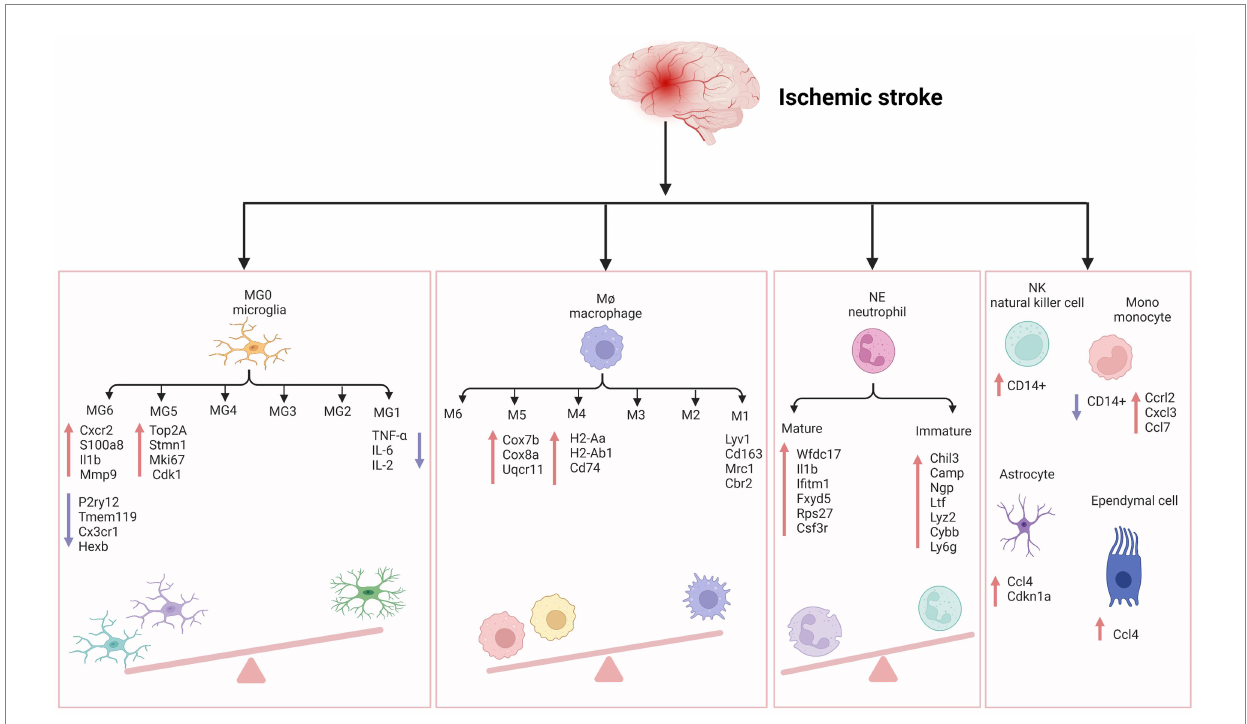
FIGURE 1 The inflammatory reaction of ischemic stroke. MG, microglia; Cxcr2, cxc chemokine receptor 2; Il1b, interleukin-1 beta; Mmp-9, matrix metallopeptidase 9; P2ry12, recombinant purinergic receptor P2Y, G protein poupled 12; Tmem119, transmembrane protein 119; Cx3cr1, c-x3-c motif chemokine receptor 1; Hexb, hexosaminidase subunit beta; Top2A, DNA topoisomerase II alpha; Stmn1, stathmin1; Mki67, marker of proliferation ki-67; TNF- α , tumor necrosis factor- α ; IL-6, interleukin- 6; IL-2, interleukin-2; Cdk1, cyclin-dependent kinases 1; Cox7b, cytochrome c oxidase subunit 7b; Cox8a, cytochrome c oxidase subunit 8a; Uqcr11, ubiquinol-cytochrome c reductase, complex III subunit XI; H2-Aa, histocompatibility 2, class II antigen A, alpha; H2-Ab1, histocompatibility 2, class II antigen A, beta 1; Mrc1, mannose receptor C-Type 1; Cbr2, carbonyl reductase 2; NE, neutrophil; Wfdc17, WAP four-disulfide core domain 17; Ifitm1, interferon induced transmembrane protein 1; Fxyd5, FXYD Domain Containing Ion Transport Regulator 5; Rps27, Ribosomal Protein S27; Csf3r, colony stimulating factor 3 receptor; Chil3, Chitinase-3-like protein 3; Ltf, lactotransferrin; Lyz2, lysozyme 2; Cybb, cytochrome b-245 beta chain; Ly6g, lymphocyte antigen 6 complex locus G6D; NK, natural kill cell; Mono, monocyte; Ccrl2, c-c motif chemokine receptor like 2; Cxcl3, c-x-c motif chemokine ligand 3; Ccl7, c-c motif chemokine ligand 7; Ccl4, c-c motif chemokine ligand 4; Cdkn1a, cyclin dependent kinase inhibitor 1a. Figure was created with